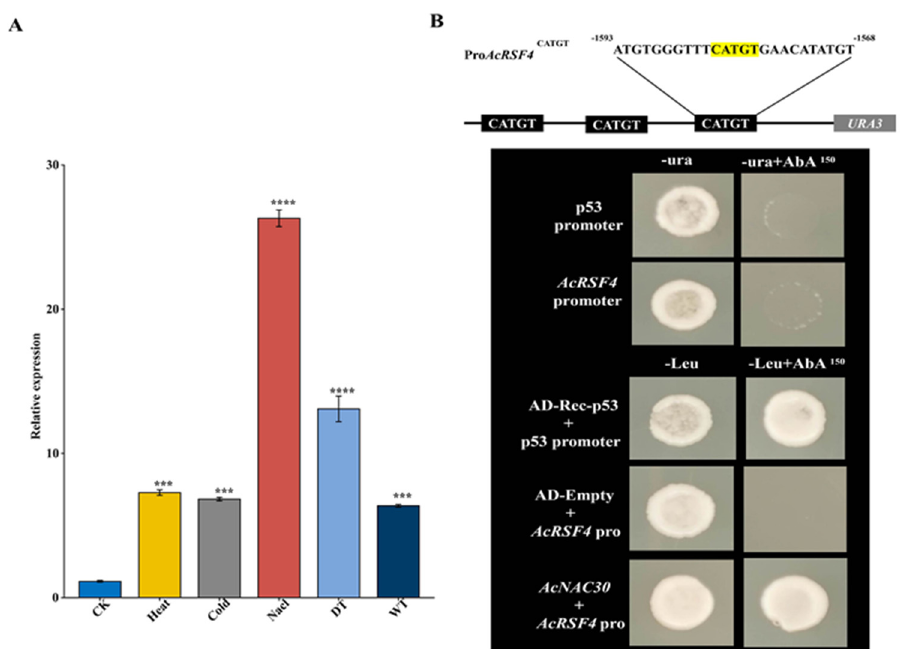
Figure 11. Identification of AcNAC30 transcription factor modulating AcRFS4 in kiwifruit. ( A ) Ex- pressions analysis of AcNAC30 under abiotic stresses. ( B ) Interaction of AcNAC30 with the promoter of AcRFS4 in the Y1H assay. Three biological replicates calculated the error bars. Asterisks indicated the corresponding gene significantly up-or down-regulated under the different treatments using t -test (*** p < 0.001, **** p <